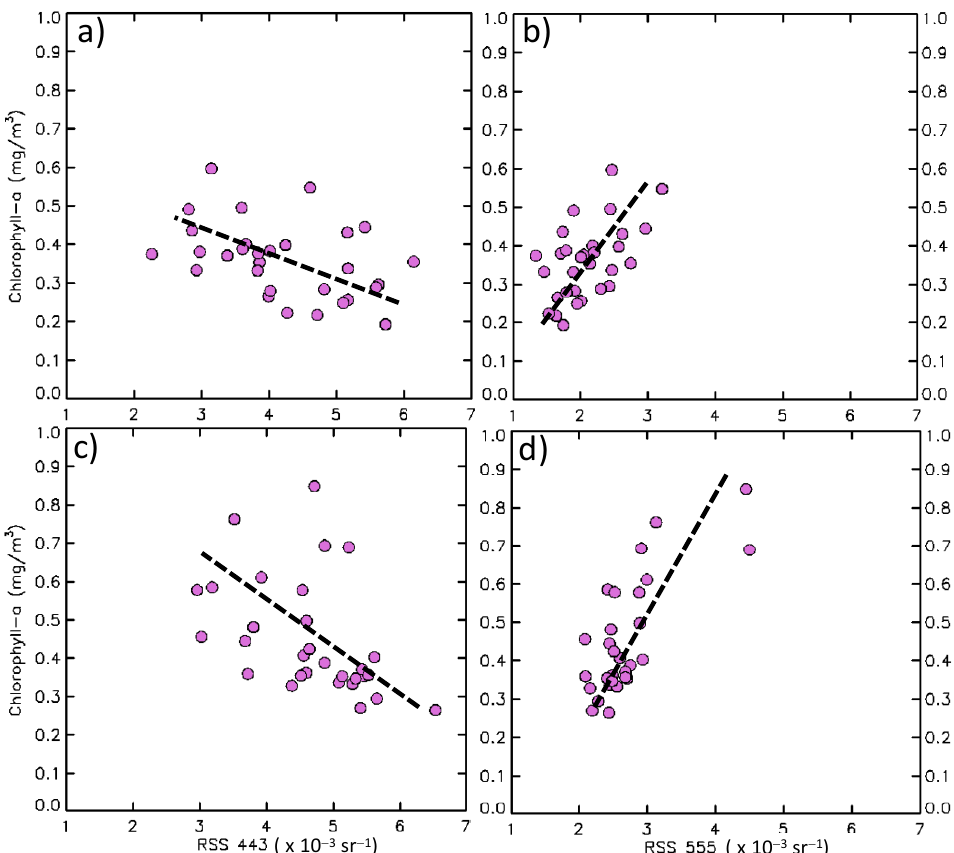
Figure 6. The scatter plots of monthly data of December, January, and February for ( a ) Rrs 443 vs. Chl-a and ( b ) Rrs 555 vs. Chl-a averaged from the first area in Figure 3a; ( c ) Rrs 443 vs. Chl-a and ( d ) Rrs 555 vs. Chl-a averaged from the second area in Figure 3a.